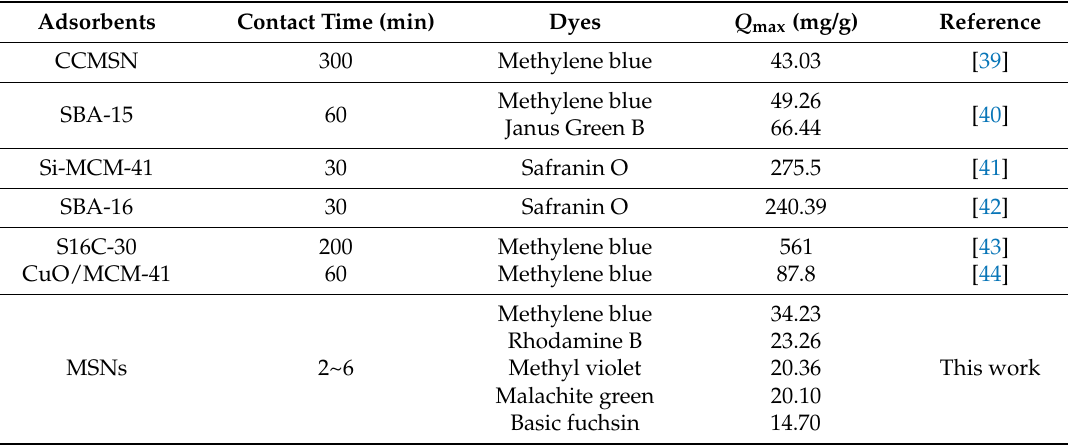
Table 2. Comparison of the maximum adsorption capacities ( Q max , mg/g) of other reported silica materials and MSN in this